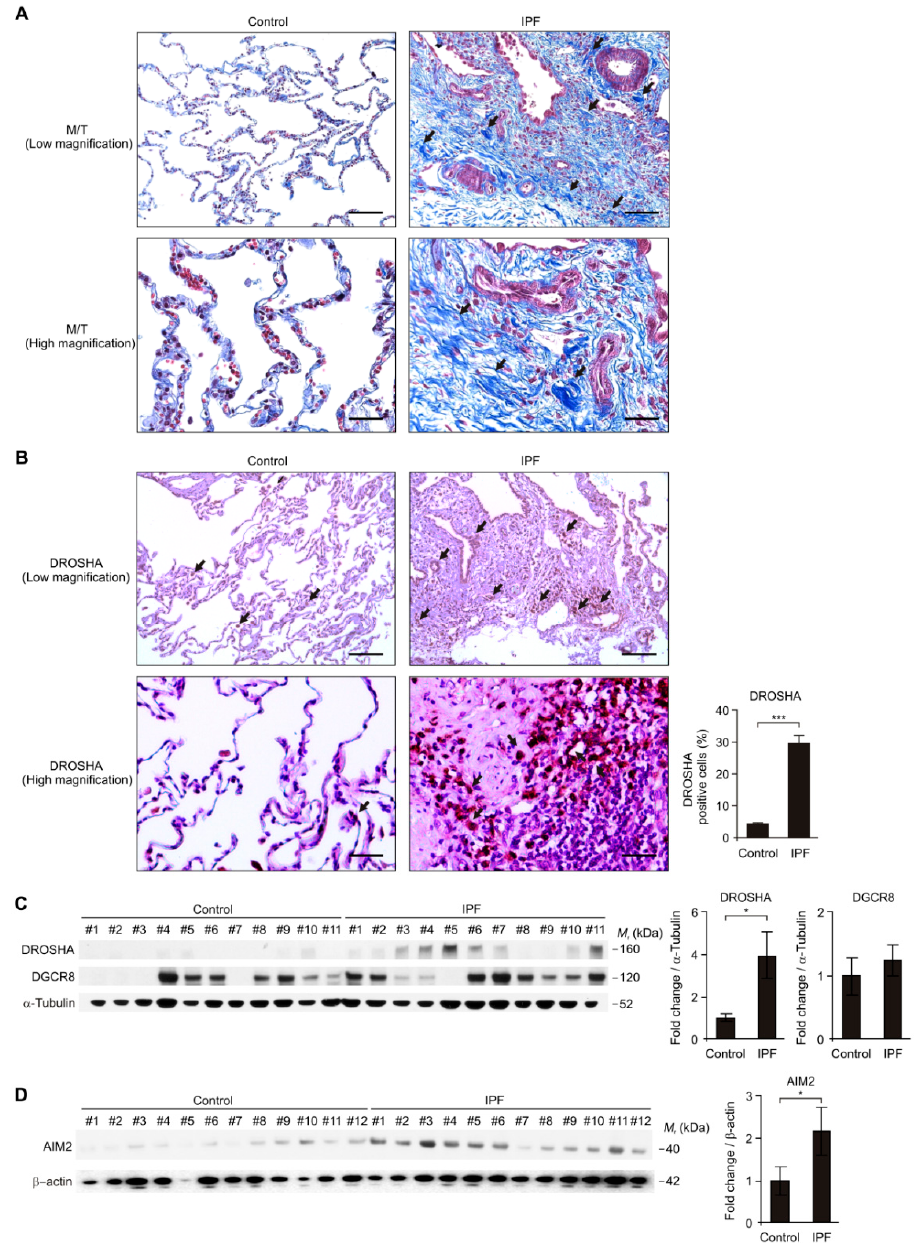
Figure 1. The DROSHA protein levels were elevated in lung tissues of patients with idiopathic pulmonary fibrosis (IPF). ( A ) Representative immunohistochemistry image of fibrosis by Masson’s trichrome (M / T) staining in lung tissues from patients with IPF (IPF) or non-IPF patients (Control). Positive area and cells are indicated by black arrow. In the low magnification image (top), scale bars are 200 µ m. In the high magnification image (bottom) scale, bars are 50 µ m. Results are representative of three independent experiments. ( B ) Representative immunohistochemistry image (left) of DROSHA and quantification of DROSHA-positive cells (the percent of DROSHA-positive cells in total 100 cells in 10 individual images per group) (right) in lung tissues from patients with IPF (IPF, n = 12) or non-IPF patients (Control, n = 9). Positive area and cells are indicated by a black arrow. In low magnification image (top), scale bars are 200 µ m. In high magnification image (bottom) scale, bars are 50 µ m. ( C ) Representative immunoblot analysis for DROSHA and DGCR8 (left) and densitometry quantification of DROSHA and DGCR8 levels (normalized to levels of α -tubulin) (right) from lung tissues from patients with IPF (IPF, n = 11) or non-IPF patients (Control, n = 11). ( D ) Representative immunoblot analysis for absent in melanoma 2 (AIM2) (left) and densitometry quantification of AIM2 levels (normalized to levels of β -actin) (right) from lung tissues from patients with IPF (IPF, n = 12)